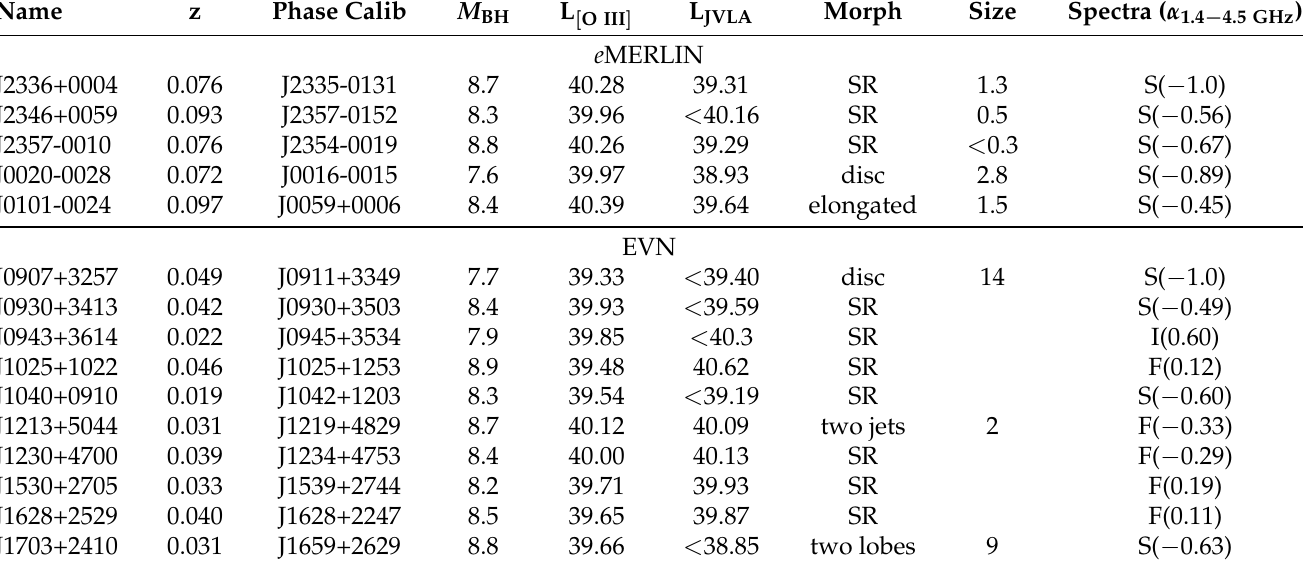
Table 1. Column description: (1) name; (2) redshift; (3) phase calibrator of the e MERLIN and EVN observations; (4) BH mass (M (cid:12) ); (5) [O III] line luminosity (erg s − 1 ); (6)–(9) JVLA core luminosity (erg s − 1 ), morphology (SR, slightly resolved or extended), size (kpc), and radio spectral type (S, steep; F, flat; I, inverted) with the 1.4–4.5 GHz JVLA spectral slope ( S ν ∝ ν α